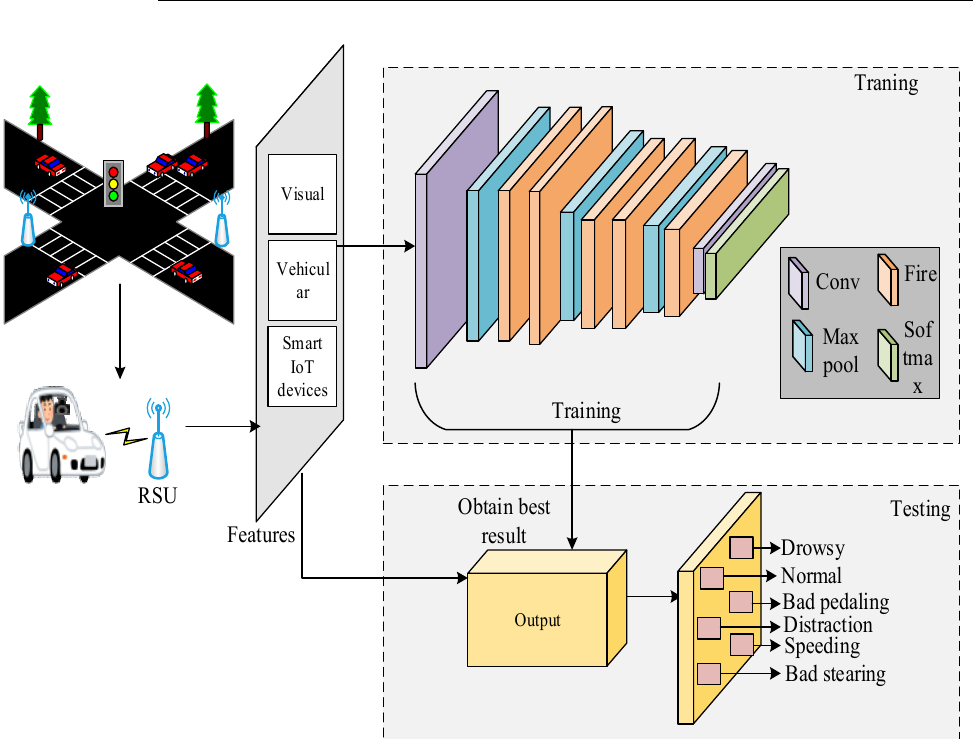
Figure 4. SqueezeNet-based driver behavior modeling.